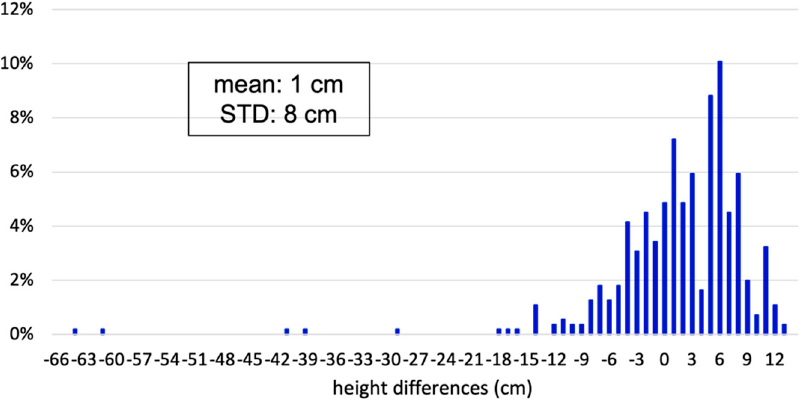
Figure 6. Histogram distribution of the height differences (GNSS-UAV) expressed in cm.